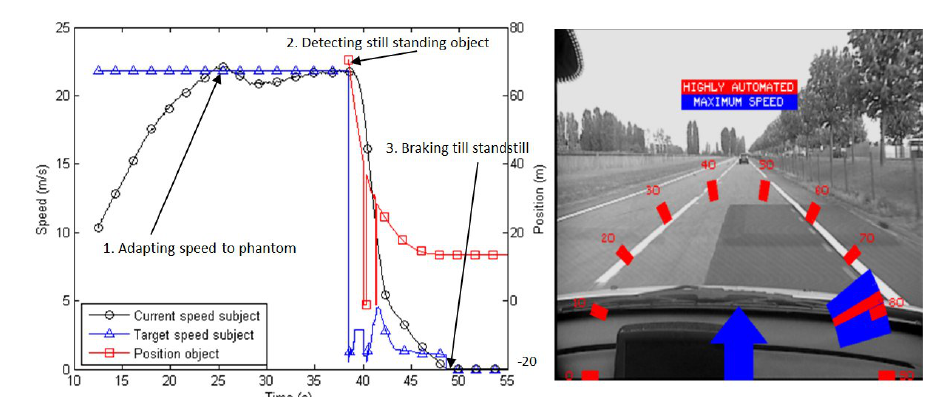
Figure 14. “Approaching a vehicle or a ghost zone”